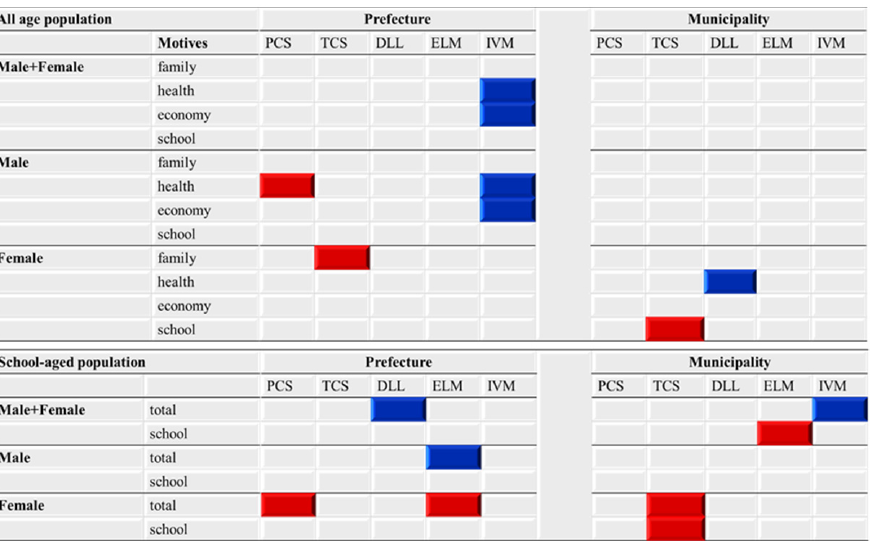
Figure 8. Summary of effects of the amount of funding provided to EFECBSC sub-divisions on Male+Female, male and female EBSMR trends of suicide mortalities caused by family-, health-, economy- and school-related motives. Blue and red columns indicate significant factors for reduced and increased EBSMR trends caused by each motive, detected by forward multiple regression analysis. DLL, development programme of leaders/listeners; ELM, enlightenment programme; IVM, intervention model programme; PCS, personal consultation support programme; TCS, telephone consultation support